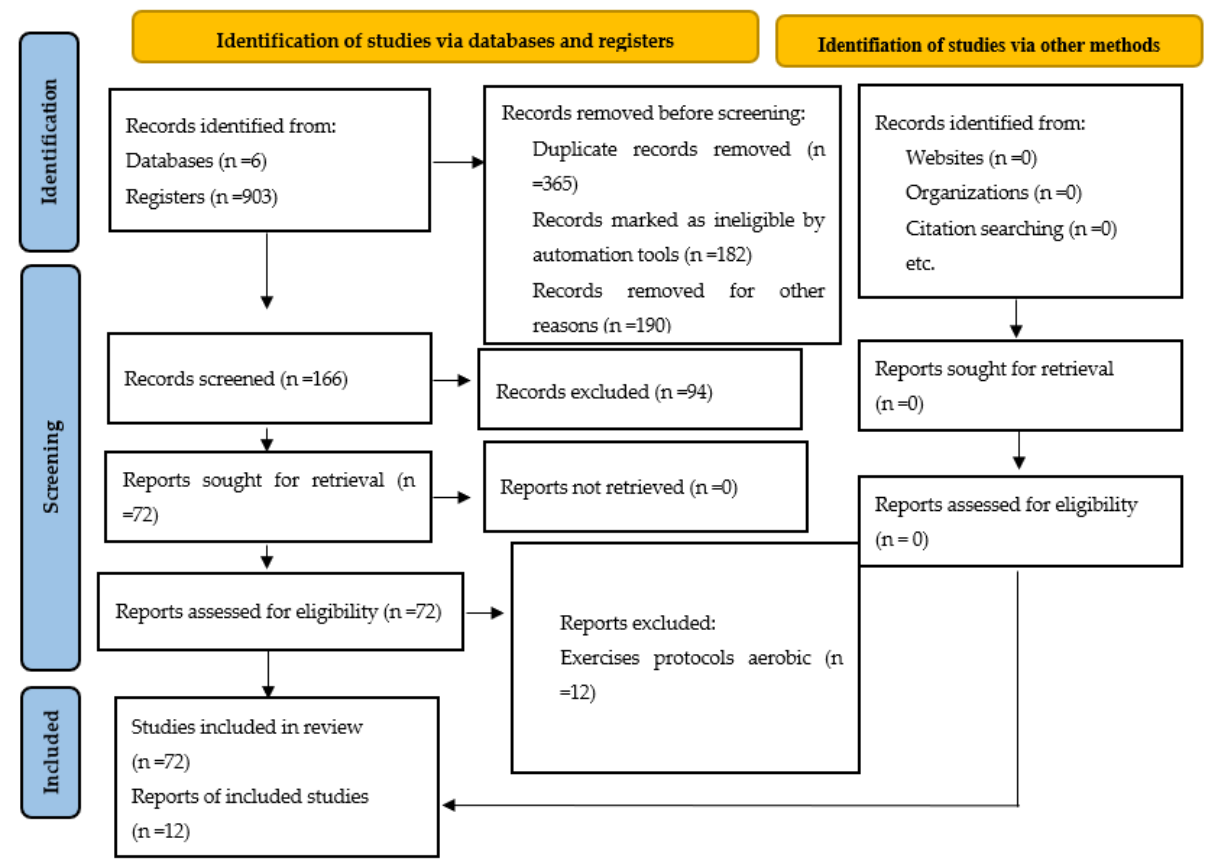
Figure 1. Diagram flow of outcomes of review.